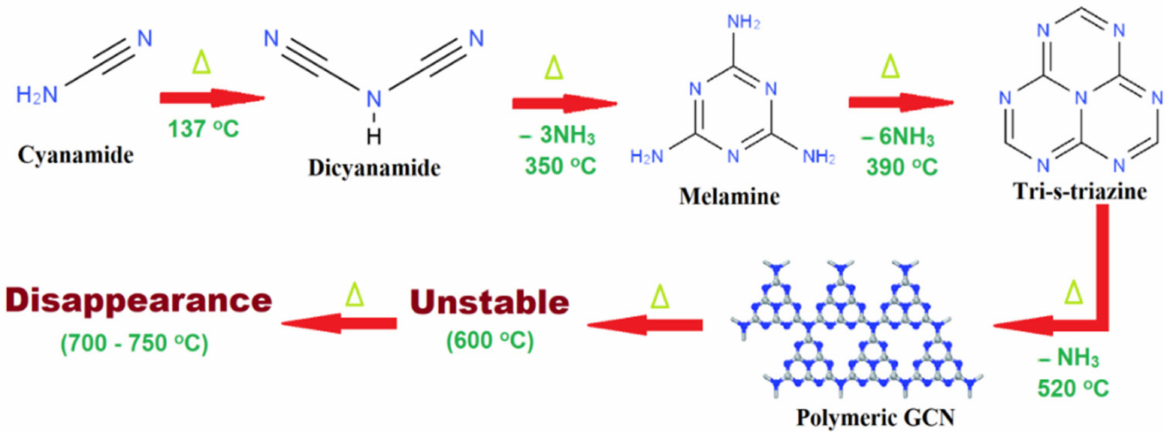
Figure 4. Reaction pathway to form GCN by using cyanamide as starting material. Adapted from